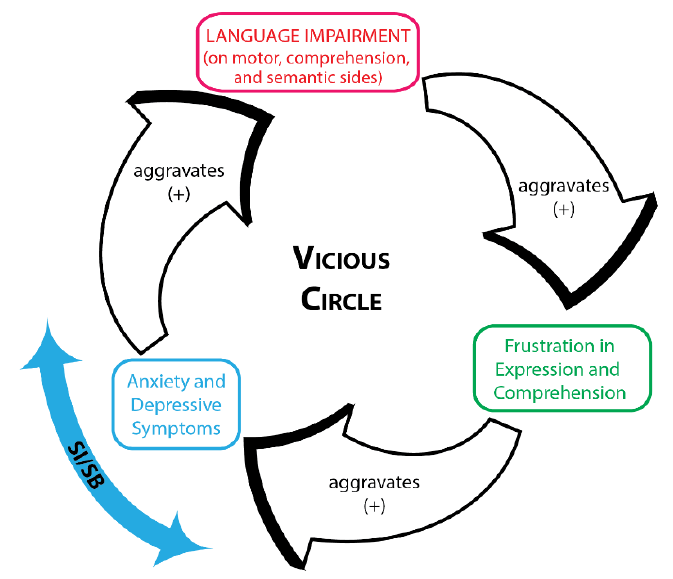
Figure 1. Vicious circle.